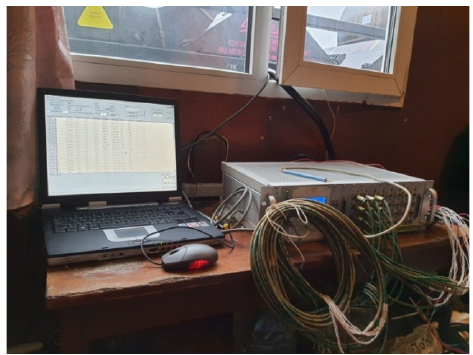
Figure 8. Strain gauge